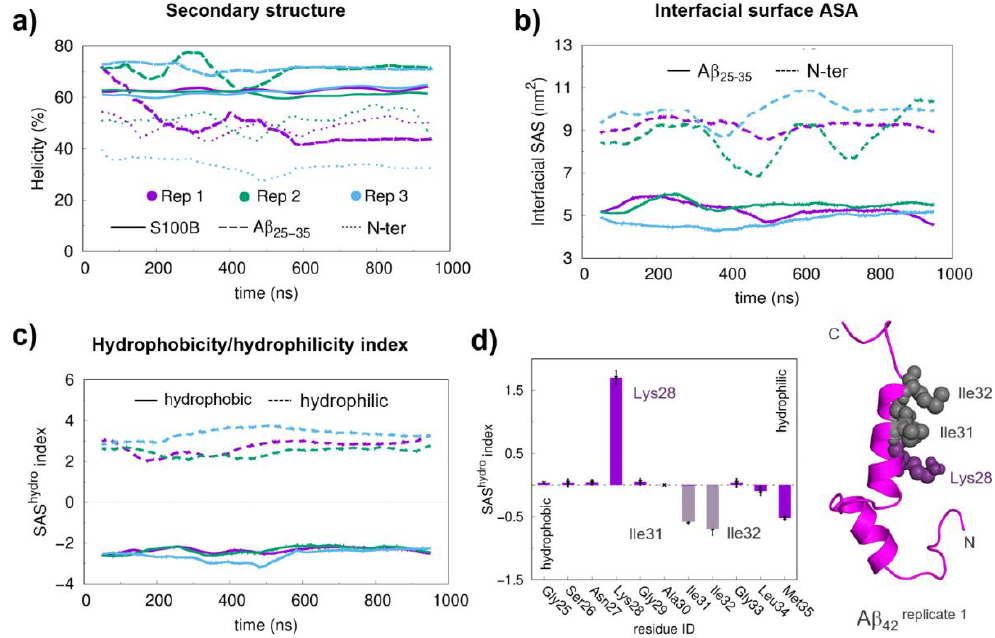
Figure 2. Structural equilibration properties, the hydrophobicity/hydrophilicity (SAS hydro ) index, and the final confor- mations for the long molecular docking (MD) simulations. ( a ) Helical content of S100B, Aβ 25–35 and Aβ N-ter during produc- tion MD runs. ( b ) Interfacial area between Aβ 25–35 /Aβ N-ter and S100B. ( c ) SAS hydro indexes for the Aβ 25–35 region at the inter- face. ( d ) Average SAS hydro index values for the hydrophobic and hydrophilic residues in the Aβ 25–35 segment. A floating window of 100 ns was used in the time series to reduce the local fluctuations. The final interfacial Solvent Acessible Surface Area (SASA) values were obtained by averaging the two interfacial areas, one mapped on the protein and another mapped on the peptide surface. The hydrophobic and hydrophilic residues in the SAS hydro index calculations were separated based on their sign (positive for hydrophilic and negative for hydrophobic residues). The average SAS hydro index values were obtained from the equilibrated segments (the last 450 ns). The error bars were calculated from the standard error of the mean between replicates. A representative structure of the Aβ 42 peptide is shown in the cartoon with the most relevant residues, in terms of SAS hydro index values, represented with spheres.